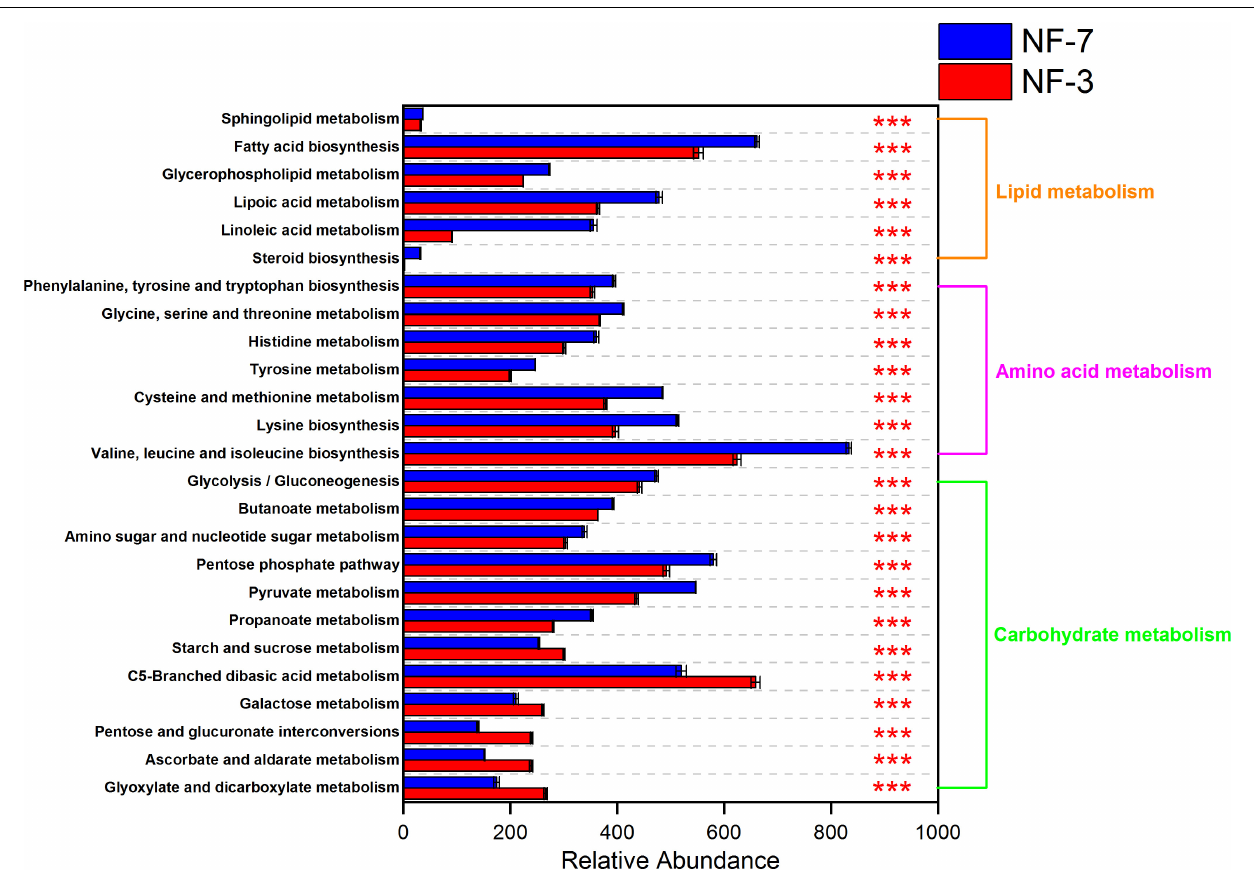
FIGURE 5 | Relative abundance of metabolic pathways at KEGG level 3. Abundance and differences in the predicted functional metagenomes of the sour porridge microbiota. Comparison of the functional pathways of microbes in the NF-3 and NF-7 groups at KEGG level 3. *** P <